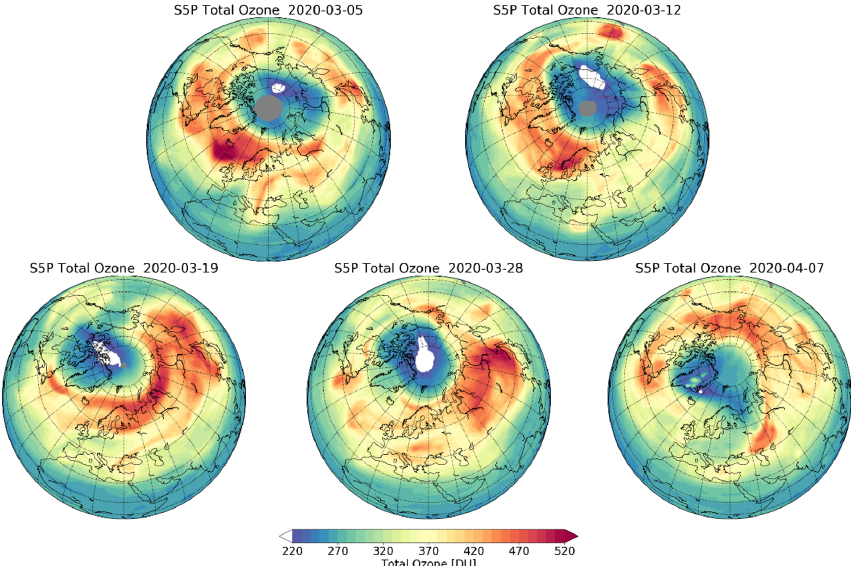
Figure 1. Total ozone column over the Northern Hemisphere on 5, 12, 19, and 28 March and 7 April 2020 measured by the TROPOMI instrument on board the Sentinel-5 Precursor (S5P) satellite. The color scale shows Dobson units (DU). The area with total ozone column values below 220DU is denoted by the white color. Grey areas near the North Pole indicate missing data during polar